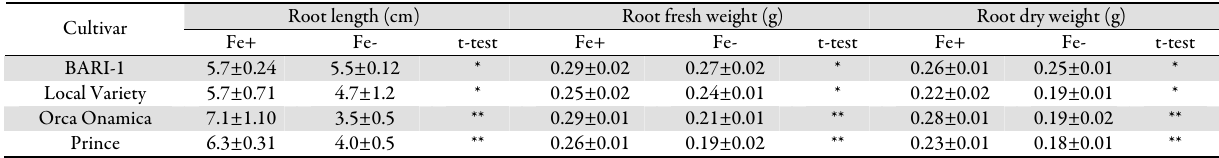
Tab. 2. Root parameters in different genotypes of okra grown on Fe sufficient (Fe+) and Fe deficient (Fe-) hydroponic culture. There were three replications for each sample. Data were taken on three weeks old plants Root length (cm) Root fresh weight (g)